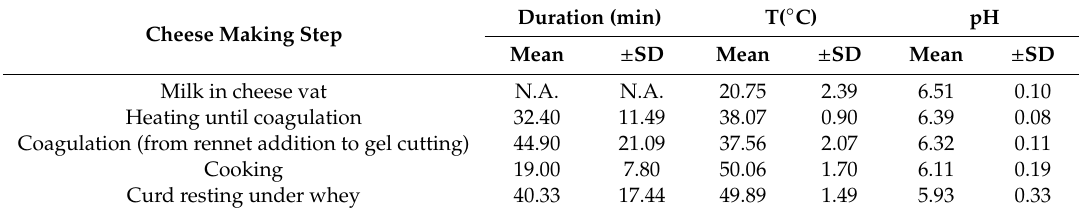
Table 1. Duration of key Nostrano Valtrompia cheese manufacture steps and relative values of pH, temperature (expressed in ◦ C) of milk and curd at the end of each cheese making